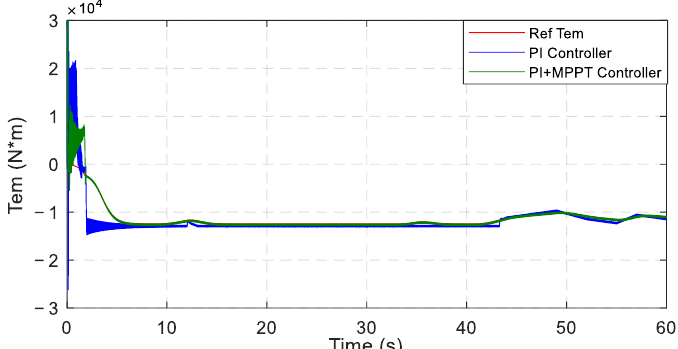
Figure 23. Electromagnetic torque ( T em ) of DFIG.